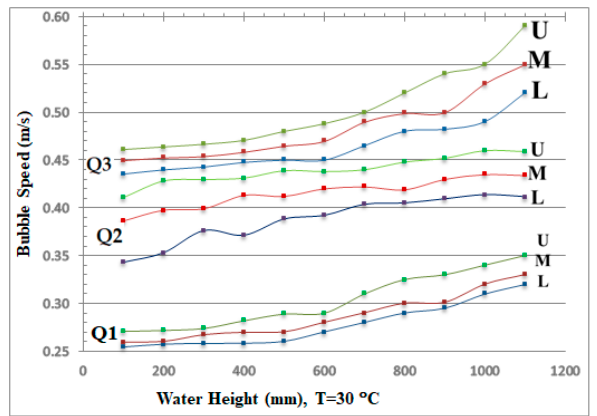
Figure 4. A sample of bubble speed as a function of water height for T = 30 ° C.